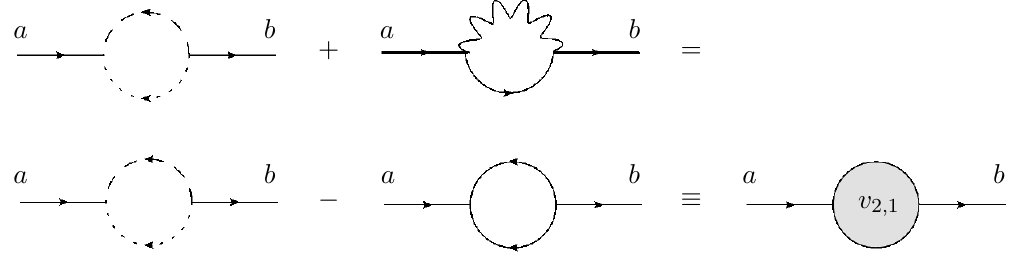
Figure 4 . The one-loop correction to the scalar propagator. In the second line we have used the relation shown in (cid:12)gure 2 for I = 1 to replace the loop diagram with the vector propagator with the one with a scalar